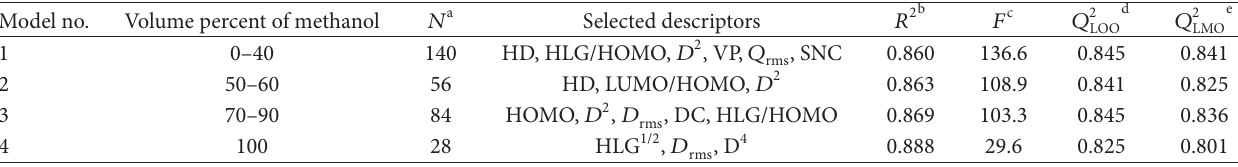
T 3: e summary of QSAR models of phenol derivatives in 0–100 volume percents of methanol in solvent mixture obtained by using quantum